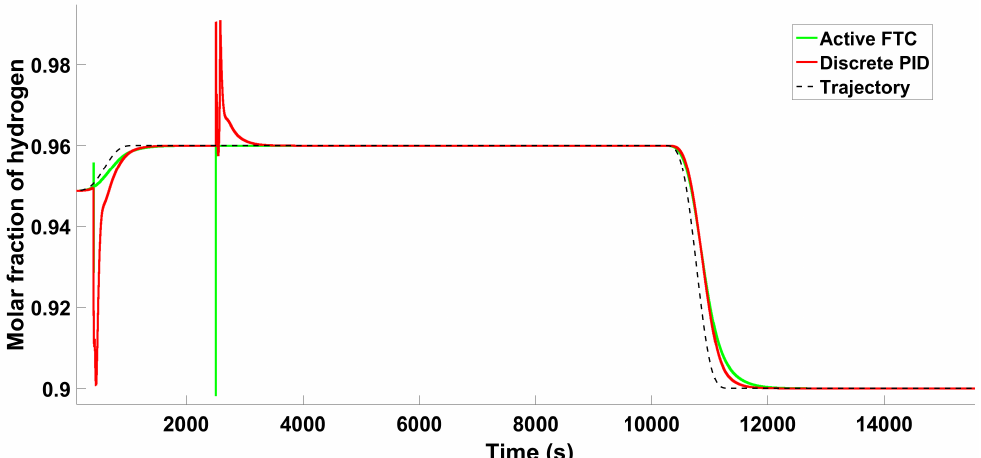
Figure 19. Scenario 1 − Step-type fault: Comparison between the discrete PID controller and the FTC applied to the reduced model (Hammerstein − Wiener) for controlling the hydrogen purity with trajectory changes and step-type